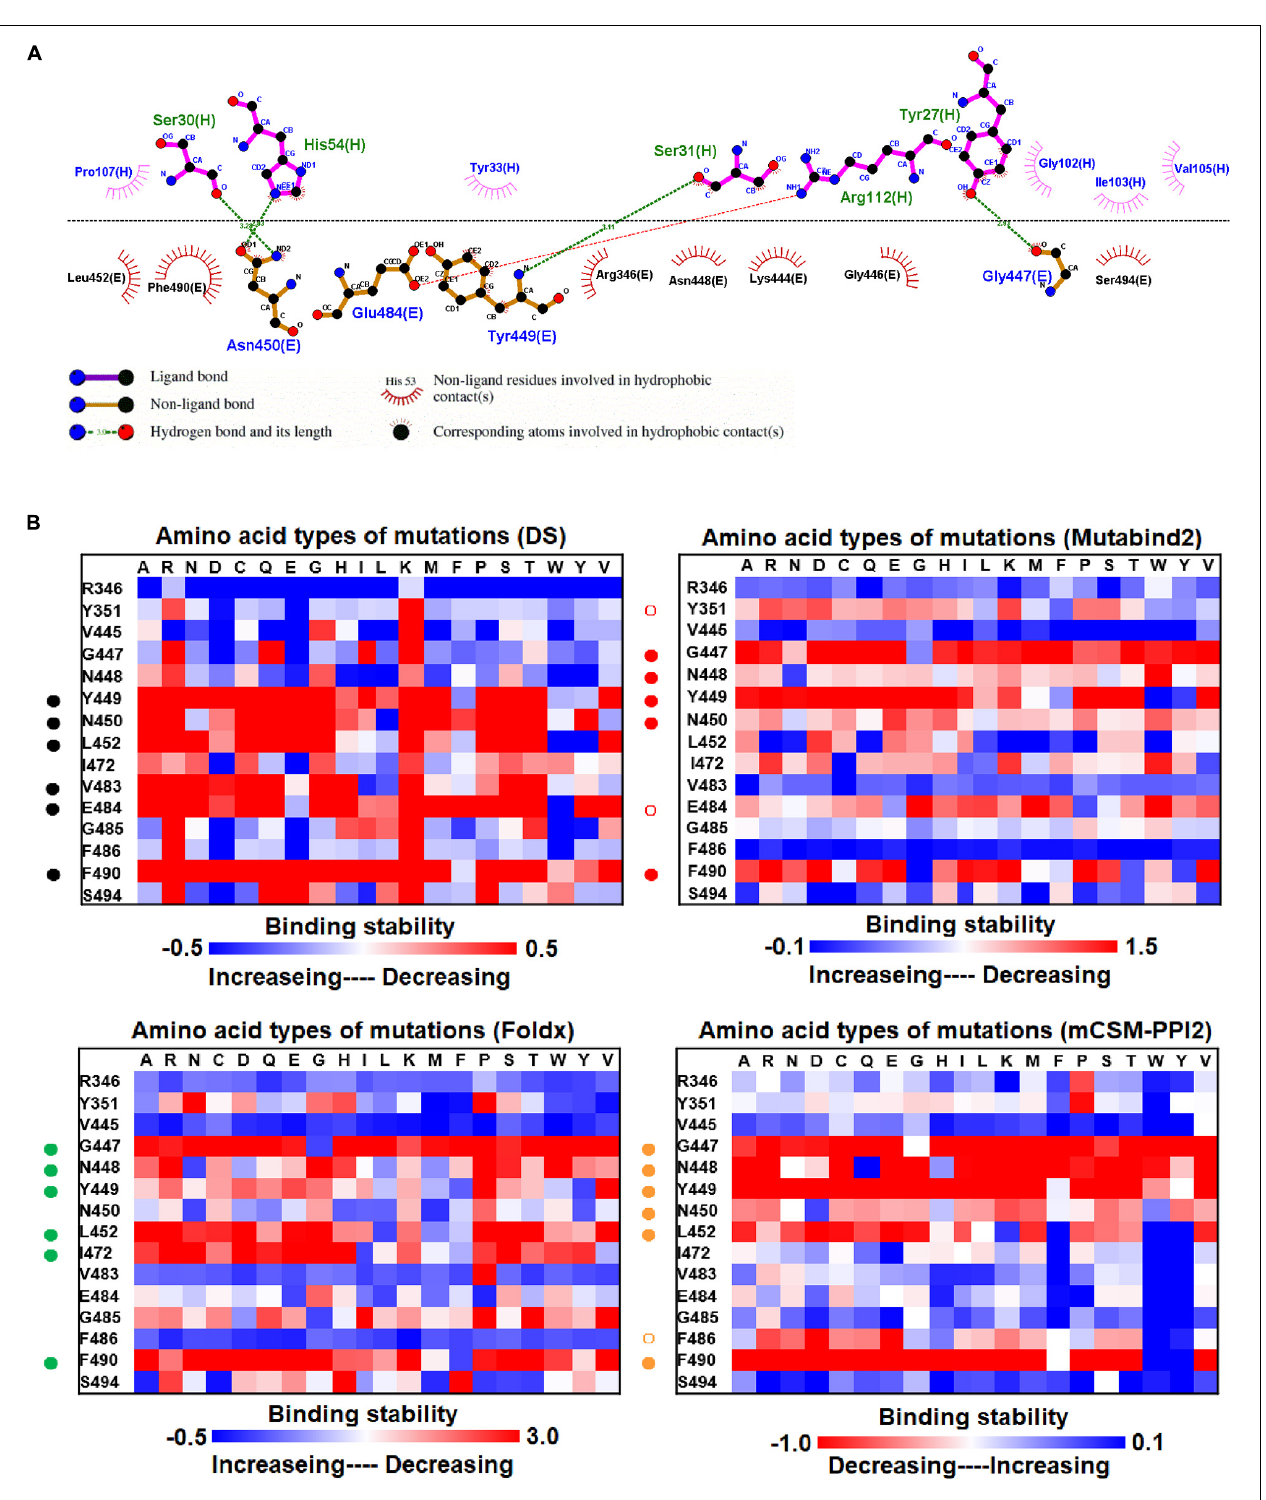
FIGURE 6 | The mutational binding stabilities of RBD variants interacting to P2B-2F6 Fab. (A) The molecular interactions of SARS-CoV-2 RBD with P2B-2F6 Fab analyzed by ligplot. The chains E and H correspond to RBD and P2B-2F6 Fab sybody, respectively. (B) The heatmap of interactive residues of RBD derived from the calculated mutational binding stabilities by using Discovery Studio 3.5 (DS), Mutabind2, FoldX, and mCSM-PPI2. The boxes of each mutations were colored with the gradient of a range between blue (stabilized binding) and red (destabilized binding). In all panels, the solid and hollow circles denote significant and moderate decreases of the binding stabilities,